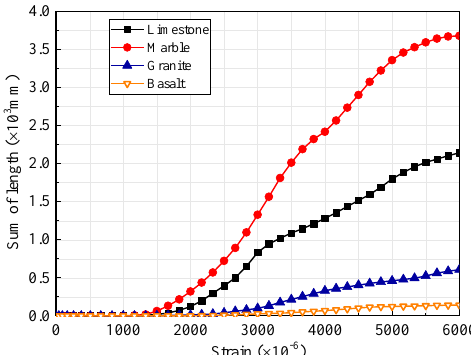
Figure 21. Effect of aggregates’ mechanical characteristics on global stress-strain relationship under compression.